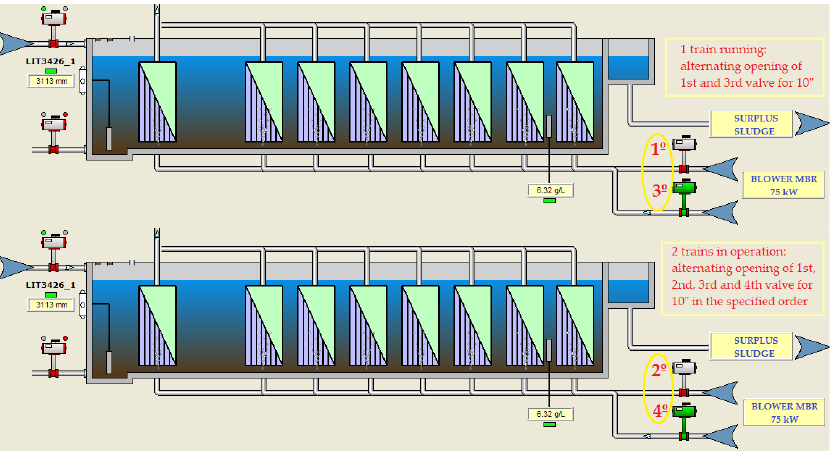
Figure 2. Actuation sequence of the aeration control valves for one or two membrane trains in